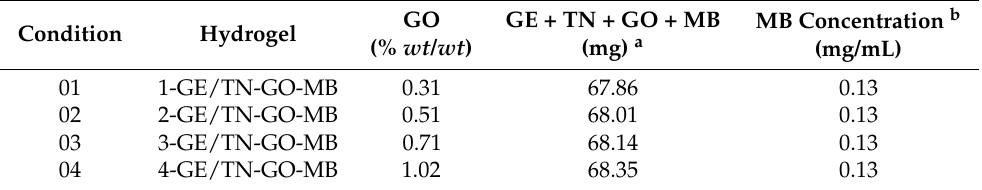
Table 3. Experimental conditions used to prepare the physical GE/TN-GO-MB hydrogels, as well as the MB concentration incorporated in the hydrogels.